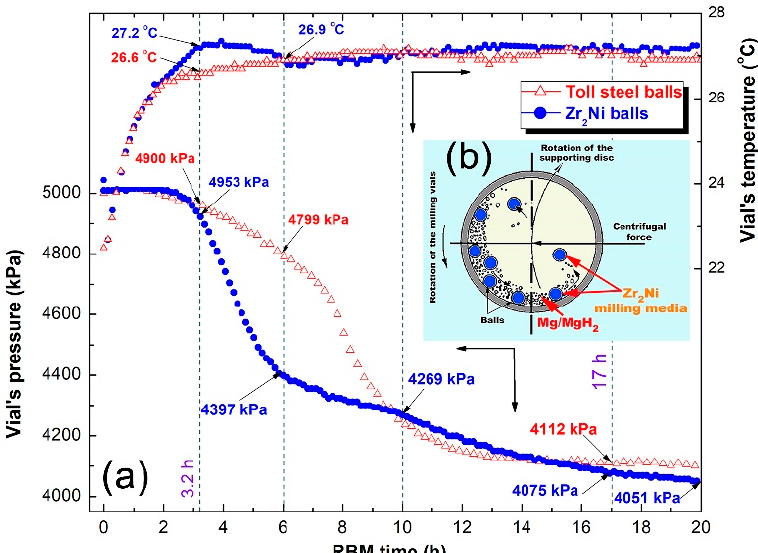
Figure 2. ( a ) The effect of milling media materials (tool steel and Zr 2 Ni) on the kinetics of hydrogenation of Mg powders induced by the RBM process. Schematic presentation shows ball–powder–ball collisions and their movements inside the vial during the RBM process conducted under 5000 kPa hydrogen pressure, using a planetary high-energy ball mill, is presented in ( b ). The MM-to-P was